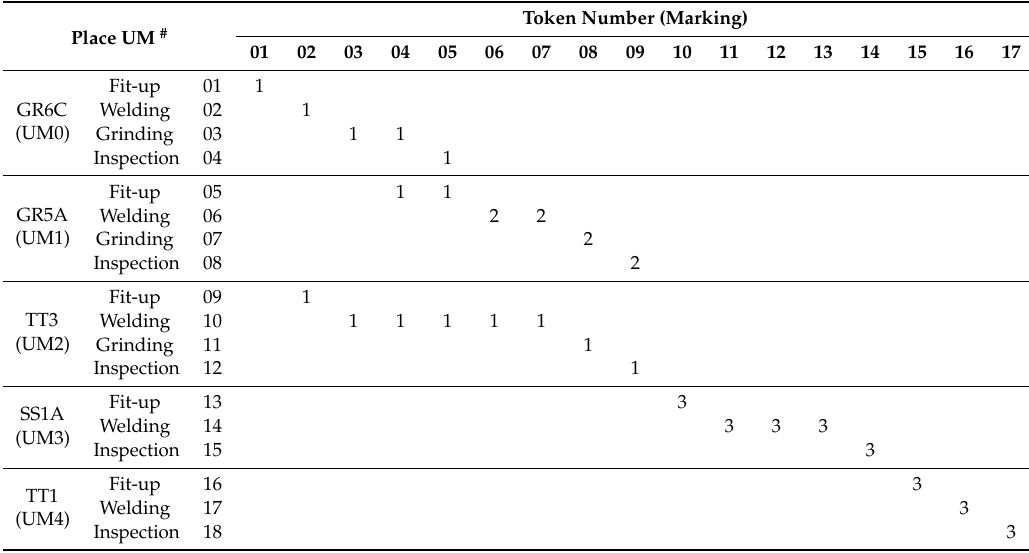
Figure 12. Process-based model through the Petri-net model (QPNet: quick Petri-net simulator). Table 4. Process-based Petri-net model analysis.